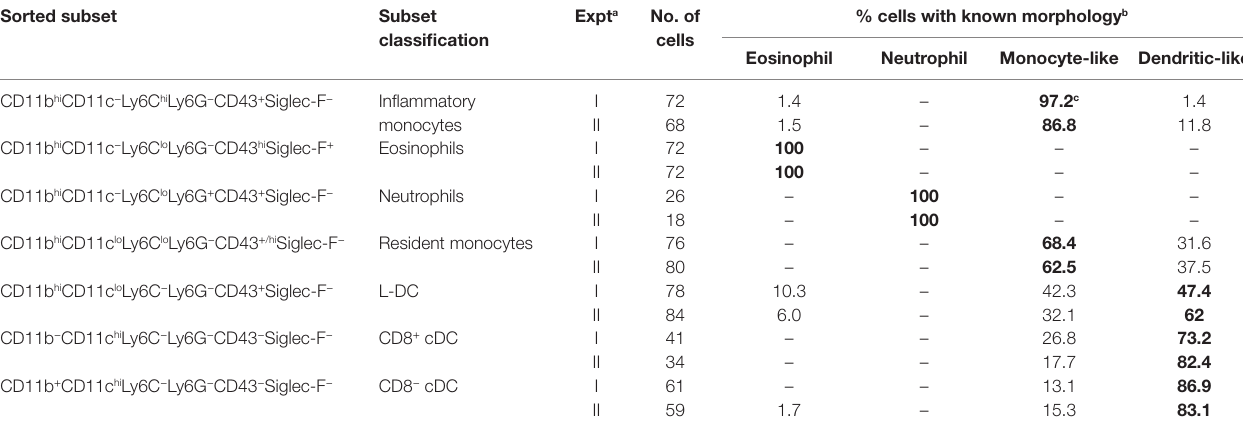
TaBle 1 | Morphological characterization of spleen dendritic and myeloid subsets. sorted